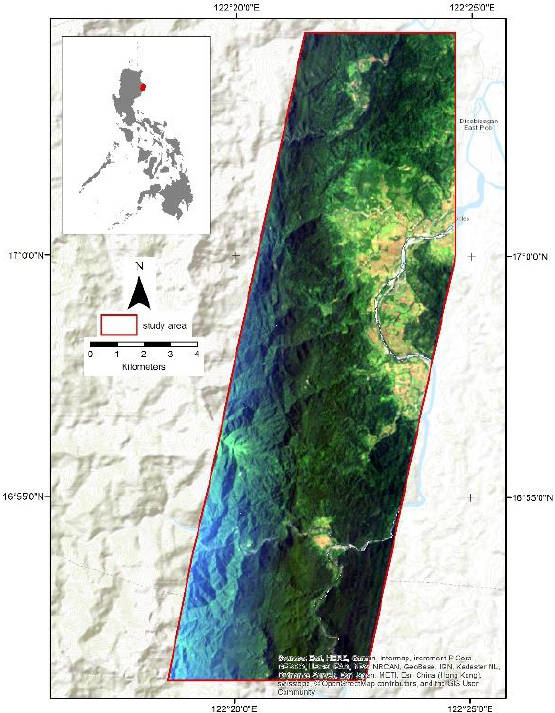
Figure 1. ( Inset) Location map of the study area in Palanan, Isabela. True color composite of Hyperion image (Band 24, Band 14, Band